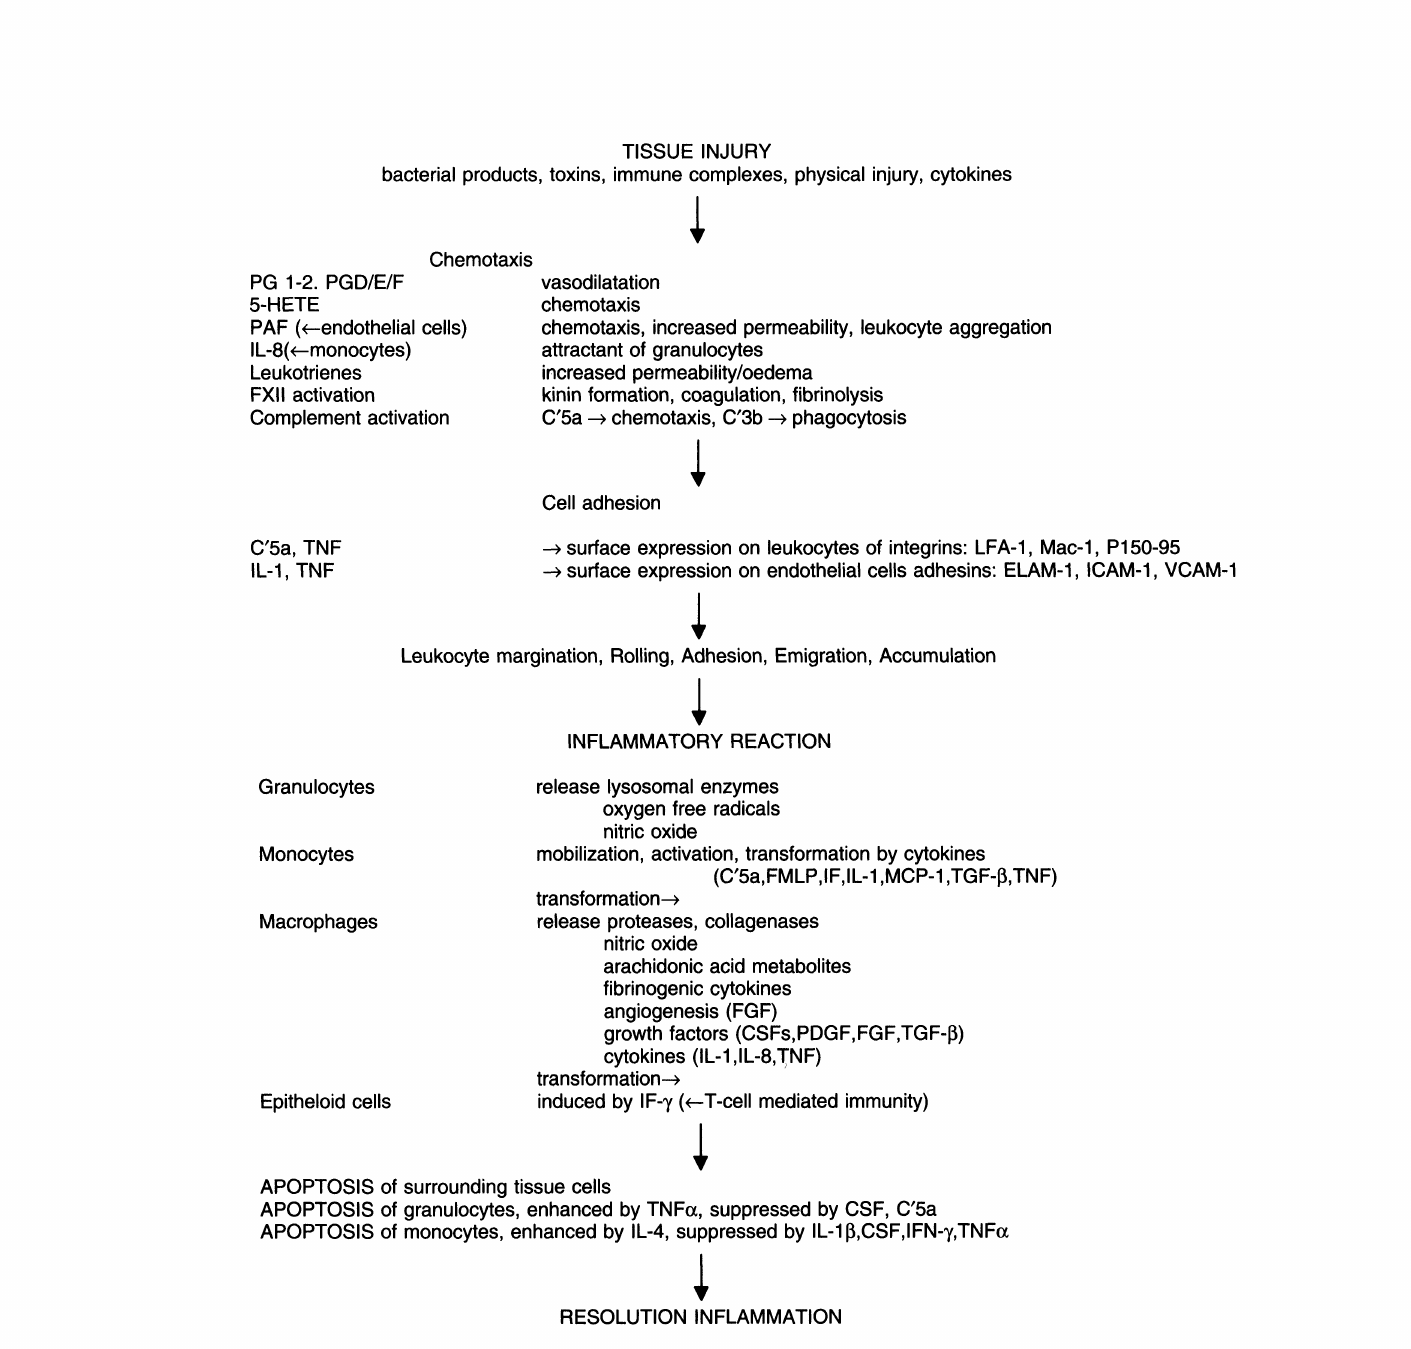
FIG. 1. The role of granulocyte recruitment or accumulation and granulocyte/monocyte apoptosis in the evolution and resolution of inflammation. Abbreviations: C’3b/C’5a, complement factors; CSFs, colony stimulating factors; FXlI, Hageman factor; FGF, fibroblast growth factor; FLMP, formyl- methionyl-leucyl-phenylalanine; HETEs, hydroperoxy derivatives of arachidonic acid; IFN, interferon; ILs, interleukins; MCP-1, monocyte chemotactic protein-I; PAF, platelet-activating factor; PDGF, platelet-derived growth factor; PG1,2, D, E, F, prostaglandins; TGF-I, transforming growth factor-I; TNF, tumour necrosis